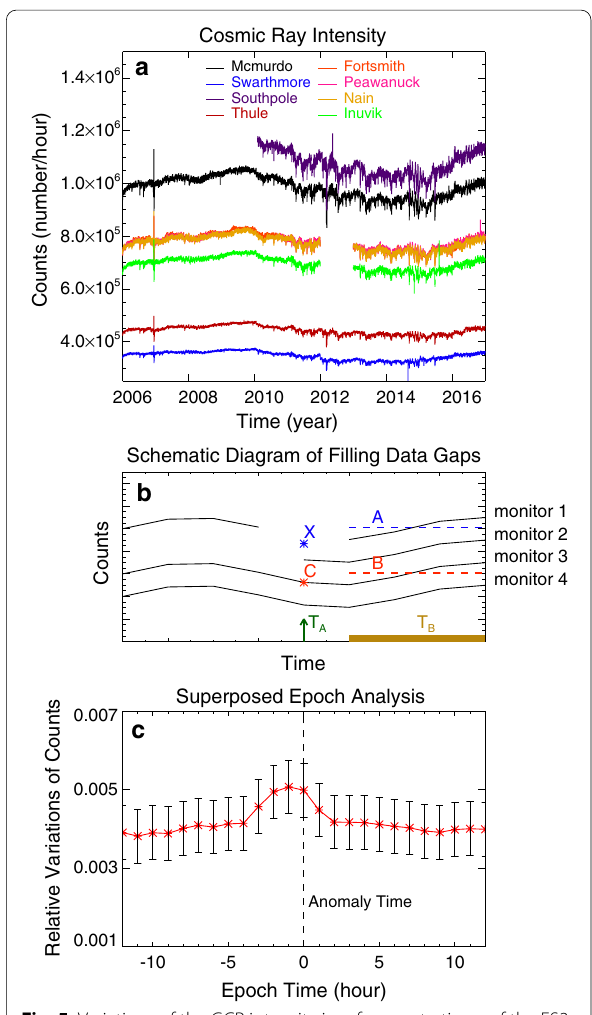
Fig. 5 Variations of the GCR intensity in reference to times of the FS3 anomalies. a Variations in the GCR intensity over years for different neutron monitors. Each curve in a different color represents the neutron counts detected by a neutron monitor. b Schematic diagram for the approach of filling data gaps of neutron monitors. The four black curves represent the variations in the neutron counts detected by four monitors. The meaning of A , B , T A , and T B has been elaborated in the main text. X is the filled value for the data gap of monitor 1 at T A , which is calculated by C A/B . c A superposed epoch analysis on × the relative variations of neutron count. Zero epoch time was set to the times of the FS3 anomalies. The mean value at each epoch time is marked with an asterisk. The black vertical lines indicate